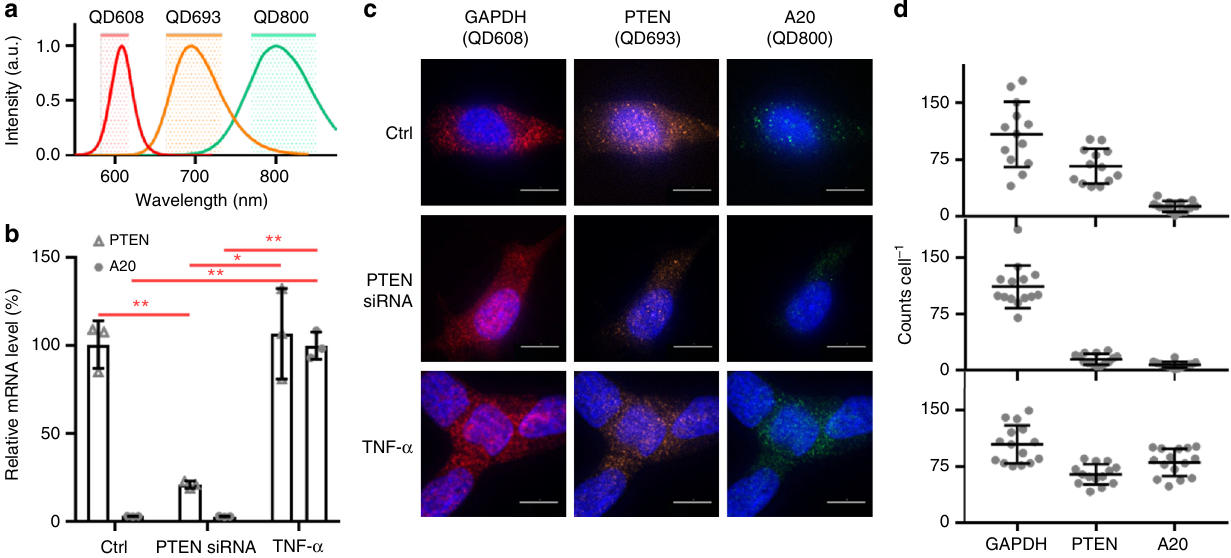
Fig. 4 Multiplexed QD-FISH quanti fi cation of three transcripts in single LNCaP cells. The three transcripts include GAPDH , PTEN, and A20 . a Emission spectra of QD608, QD693, and QD800 and corresponding emission bandpass fi lters used for imaging. b Graph shows the expressions of PTEN and A20 transcripts relative to GAPDH by qRT-PCR after cells were exposed to either anti- PTEN siRNA to knock down PTEN expression or TNF- α to induce A20 expression. Asterisks indicate: p ≤ 0.05 (*), p ≤ 0.01 (**), and p ≤ 0.001 (***); Student ’ s t -test. N = 3. c Representative QD-FISH images of single cells in each color channel corresponding to bandpass fi lters shown in panel a . QD probes were speci fi c against GAPDH (QD608), PTEN (QD693) or A20 (QD800), and cells were treated with or without anti- PTEN siRNA or TNF- α . Scale bar = 10 μ m. d Single-cell QD-FISH results are shown for GAPDH , PTEN and A20 transcripts for each of the three experimental conditions corresponding to the images in panel c . N = 15. All error bars represent s.d. A20 mRNA FISH probe sequences are shown in Supplementary Table